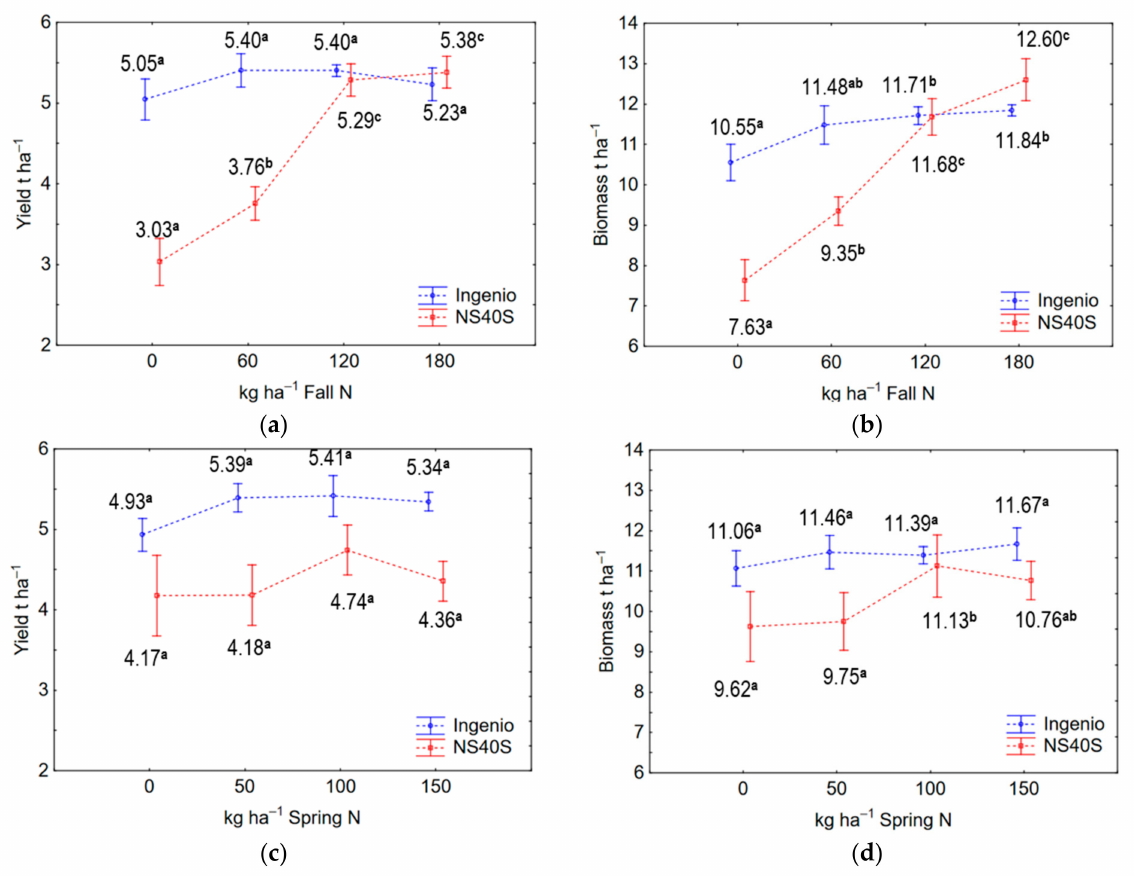
Figure 6. Effects of fall N fertilizer application ( a , b ) and spring N fertilizer application ( c , d ) on grain yield and biomass of Ingenio and NS40S wheat varieties for 2019 growing season. The letters on the graph represent different classes obtained by ANOVA with p = 0.05 level of significance.